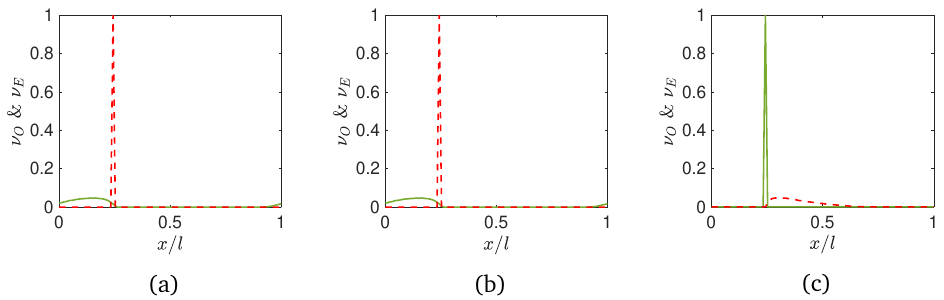
Figure 14: Distribution of the (chiral) operator evolution (green solid lines) and the (chiral) energy density peaks (red dashed lines) at sub-type-2 of type III exceptional point. We use protocol 1 with two Hamiltonians H and H with probabilities 1 / 2 A B = σ − = 0, σ + = 1 and 1 / 2. The two Hamiltonians H and H are defined with σ 0 A B A A A = − σ − = 1 / 2, σ + = − 1 (see (5) for definitions) The time durations of and σ 0 B B B / l = 1 / 40 and (a) T / l = 1 / 30, (b) T / l = 1 / 40, (c) T / l = 1 / 50. We driving are T A B B B = 10 6 in the numerical take N sample